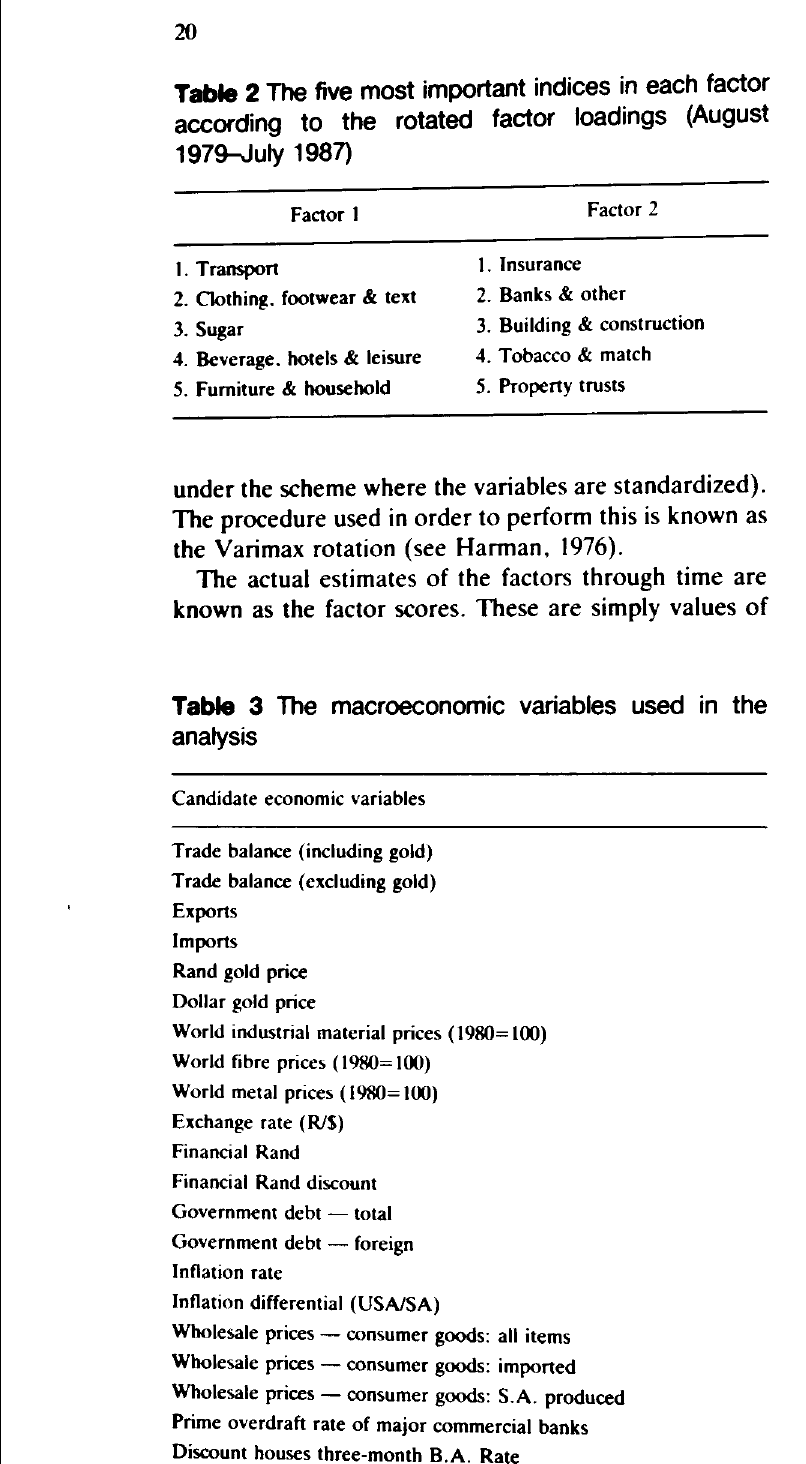
Table 2 The five most important indices in each factor according to the rotated factor loadings